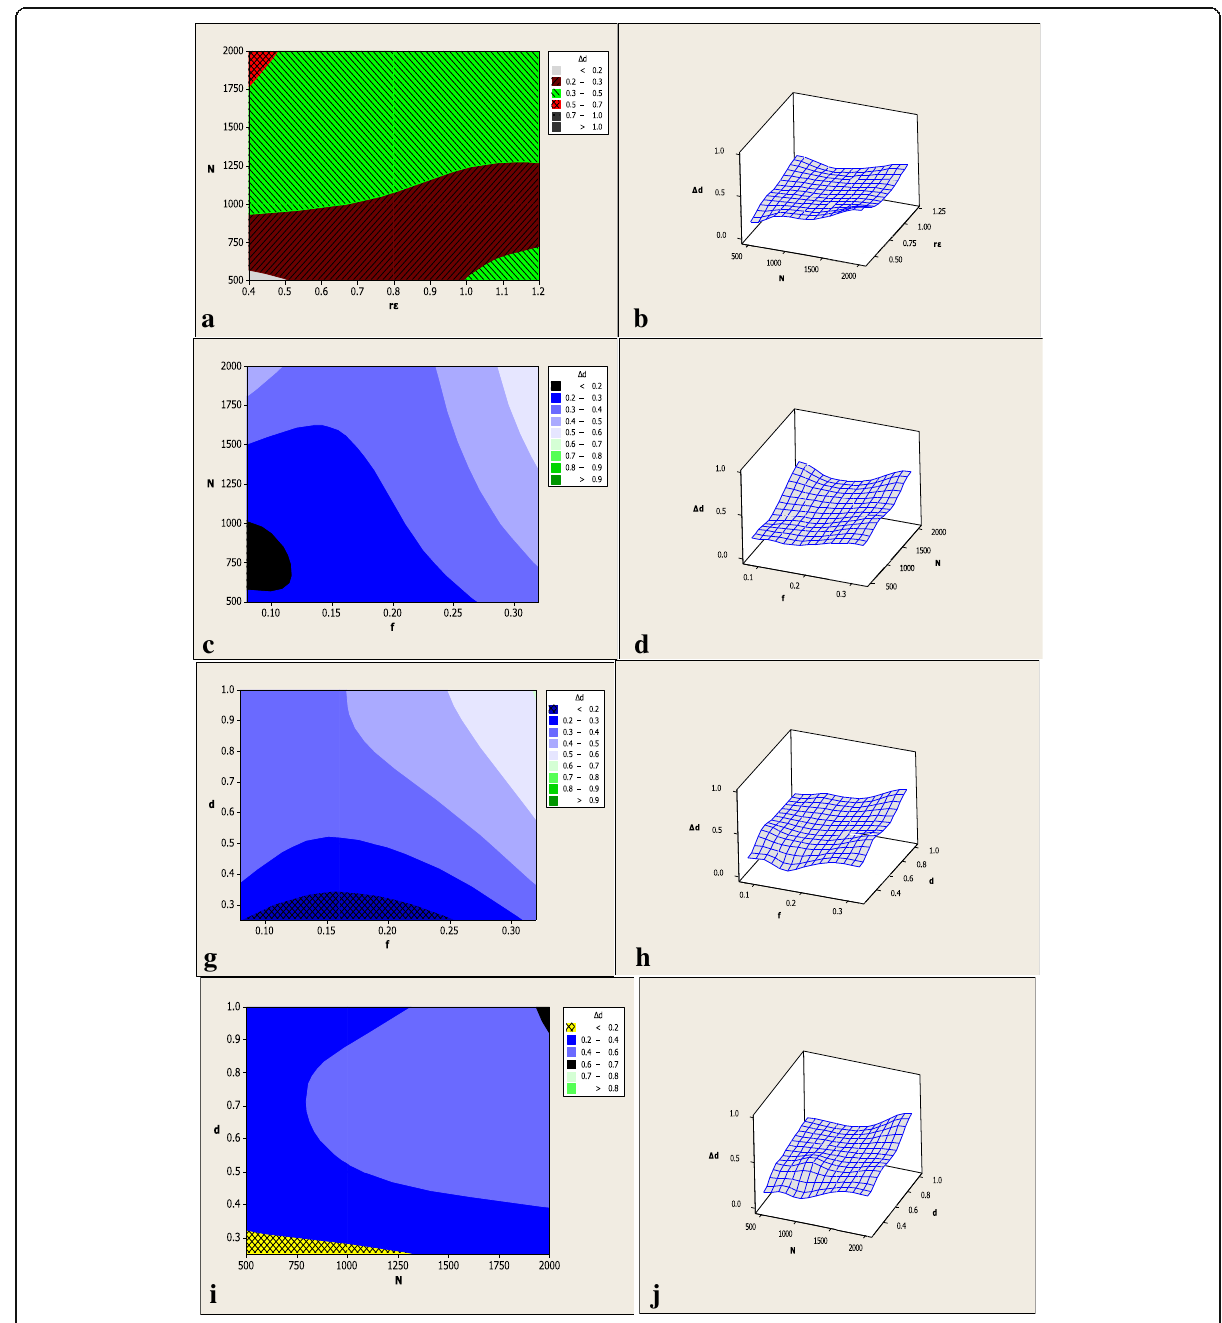
Fig. 10 Contour and 3D surface plots for the dimensional deviation ( Δ d)